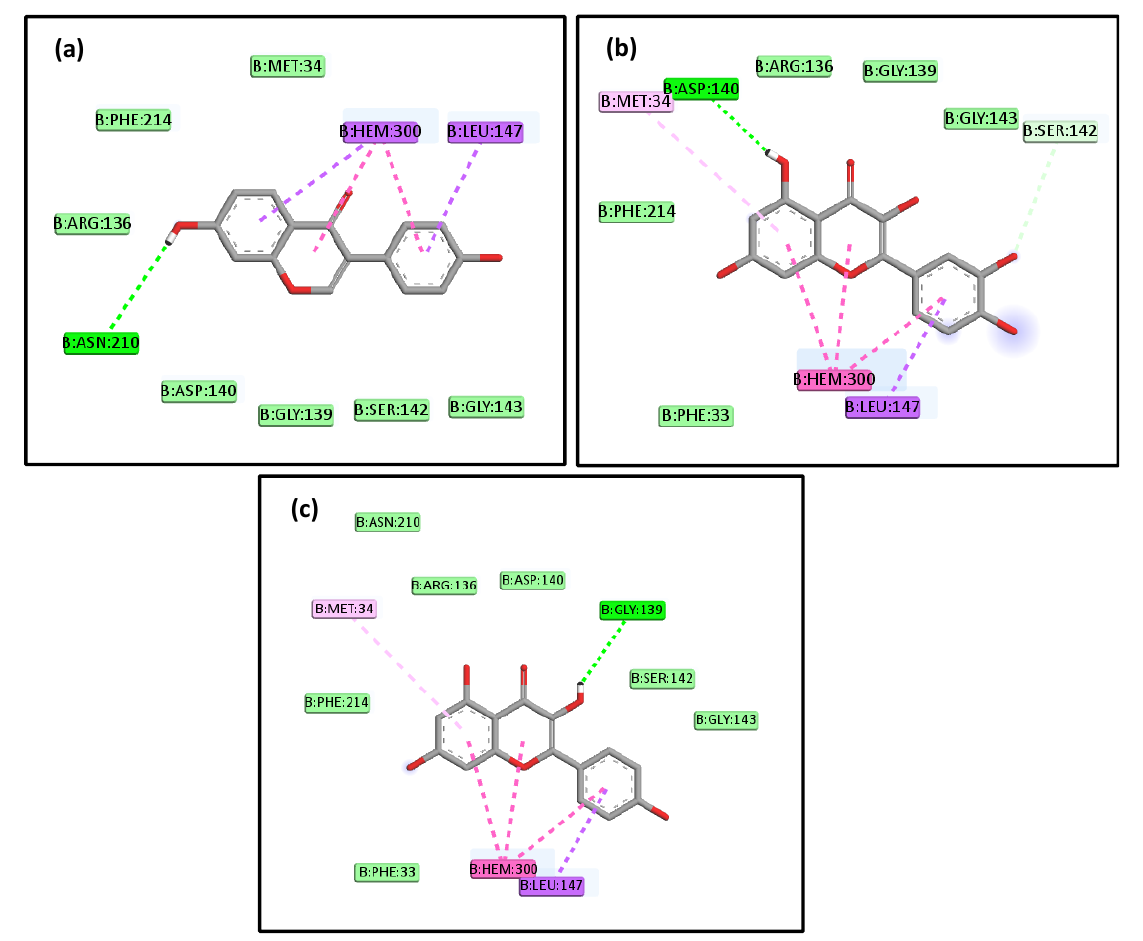
Figure 15. The 2D schematic interactions of docked daidzein ( a ), quercetin ( b ), and kaempferol ( c ) with human HO-1 (Code: 3CZY).